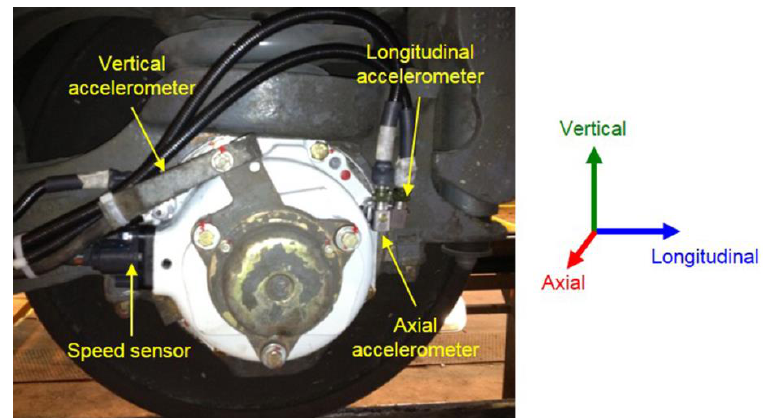
Figure 3. The location of the longitudinal, axial, and vertical accelerometers (highlighted in yellow circles) and speed sensor (highlighted in blue square) after their installation in the axle box.